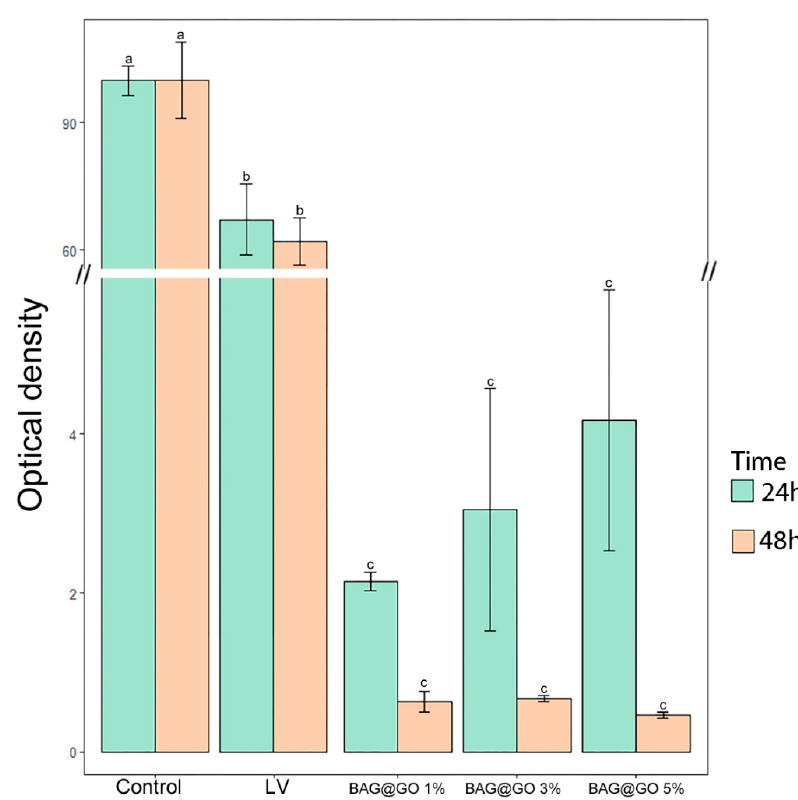
Figure 6. The difference in antibacterial properties between cured LV and BAG@GO orthodontic bonding pastes at 24 h. The same letter indicates no statistically significant difference between the groups ( p < 0.05) by Duncan’s multiple comparison test. Error bars are shown ± standard deviation.